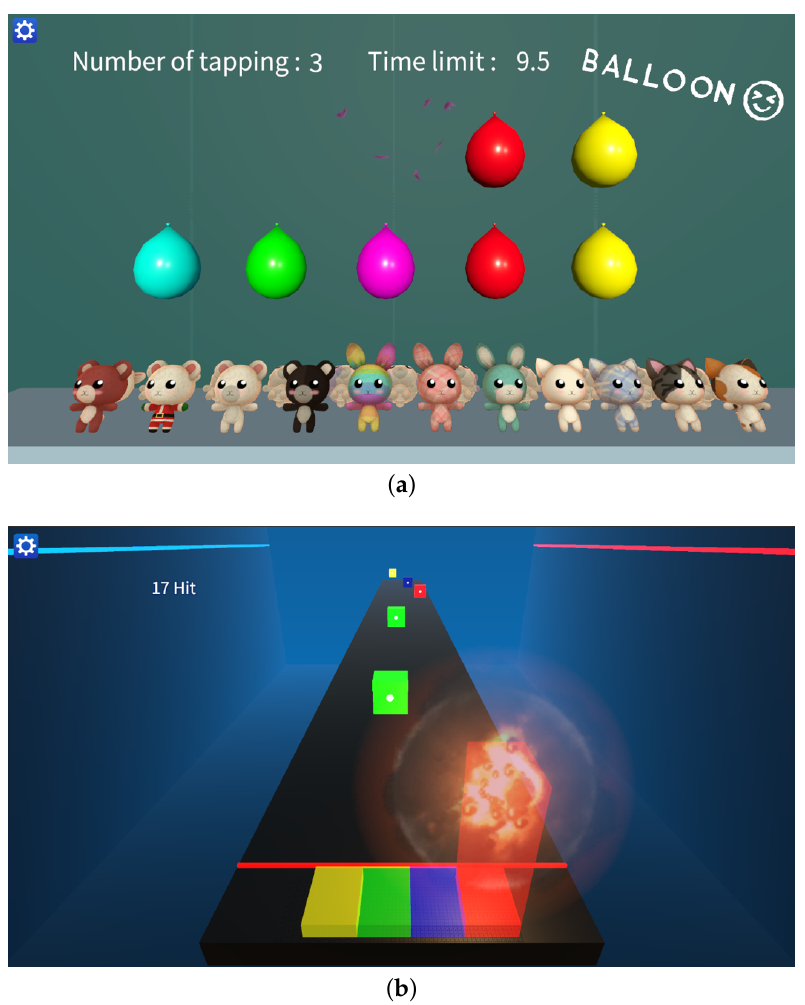
Figure 6. Contents to measure stability and accuracy of hand function using number of finger taps and presented stimuli. ( a ) Number of taps or frequency; ( b ) Tapping